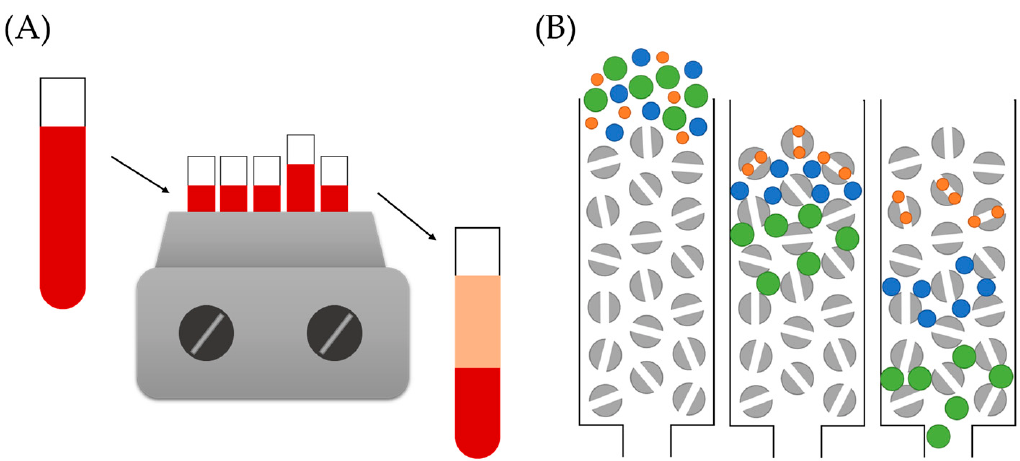
Figure 9. Two of examples of separation techniques employed for PC–NM complex isolation: ( A ) traditional centrifugation, where high-density materials form a pellet at the end of the tube while lighter components remain in solution; ( B ) size exclusion chromatography, where smaller substances follow a longer path than larger NMs, and hence are separated by size.